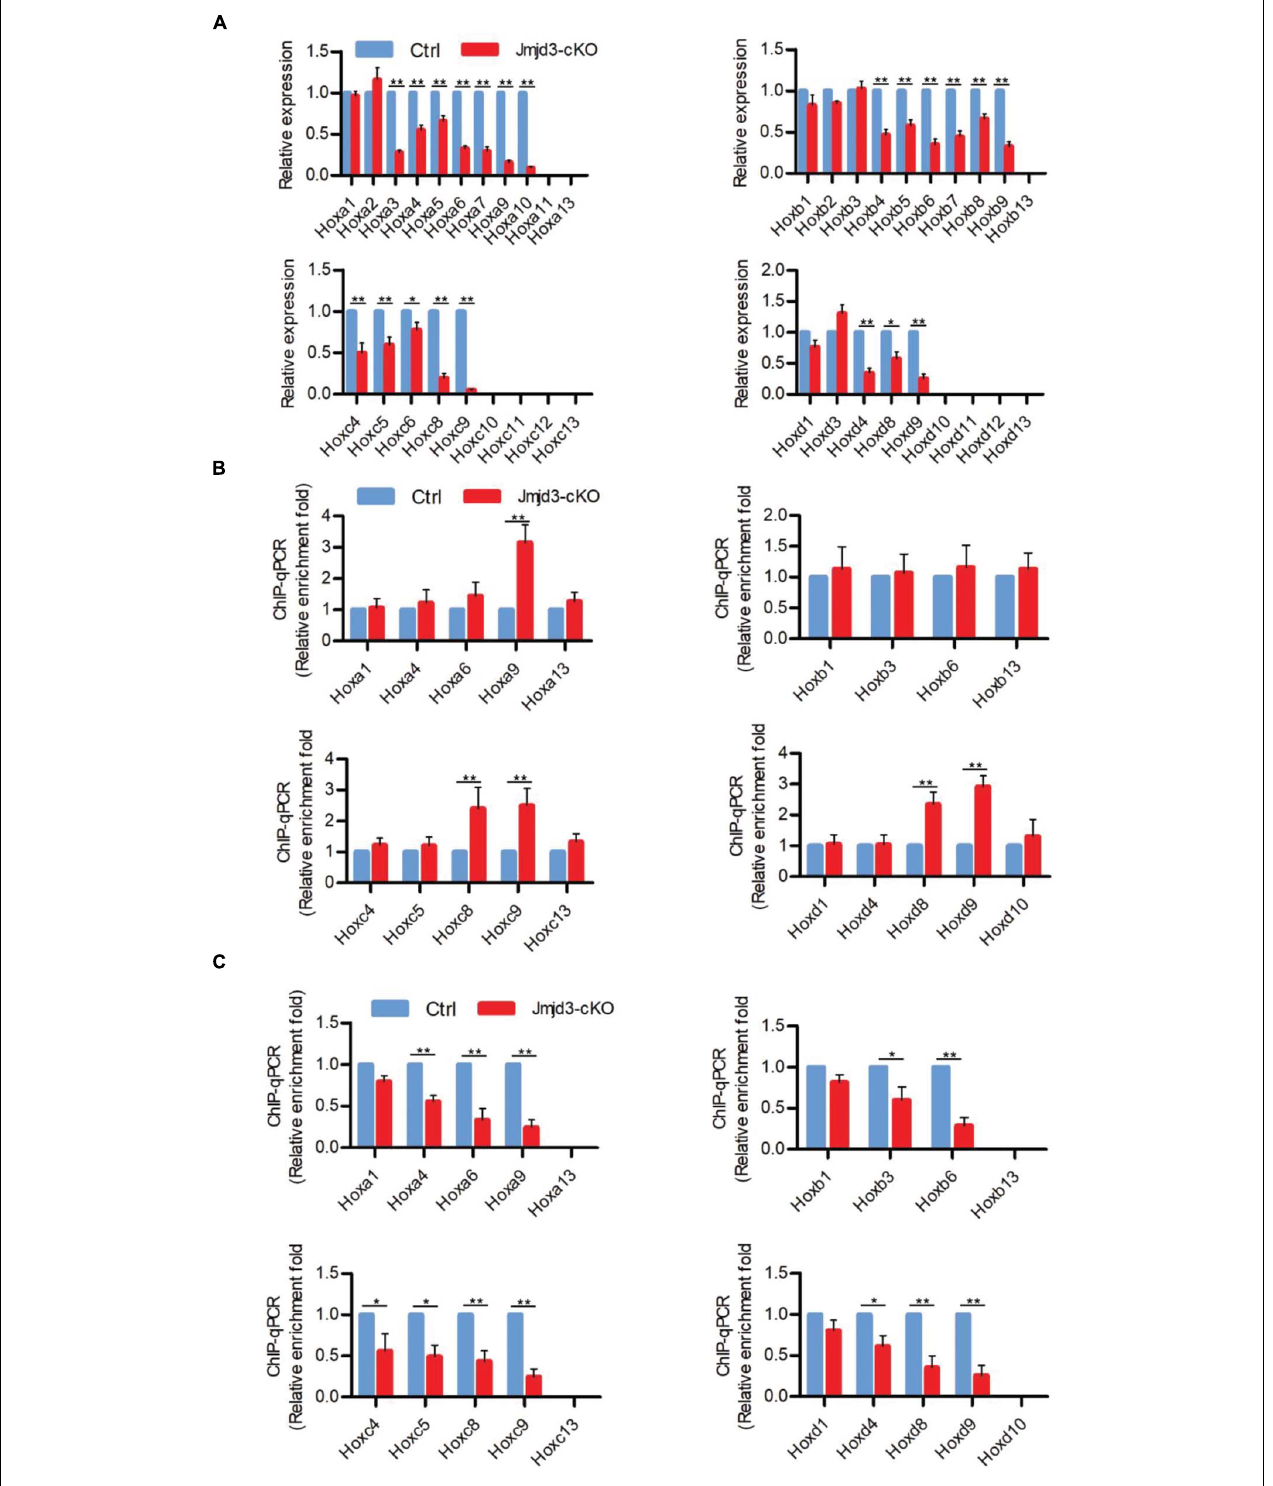
FIGURE 4 | Jmjd3 temporally activated and maintained Hox gene expression in mice. (A) The mRNA levels of Hox genes were determined by RT-qPCR in E8.5 control or Jmjd3 -cKO embryos, which were treated by tamoxifen (50 mg/kg) 12 h before. (B,C) ChIP-qPCR assays with antibodies specific for H3K27me3 (B) or Jmjd3 (C) on the Hox genes in E8.5 control or Jmjd3 -cKO embryos treated by tamoxifen (50 mg/kg) 12 h before. Bars indicate triplicate PCR reactions ± SD. Representative results of three independent experiments are shown. * p < 0.05, ** p < 0.01.